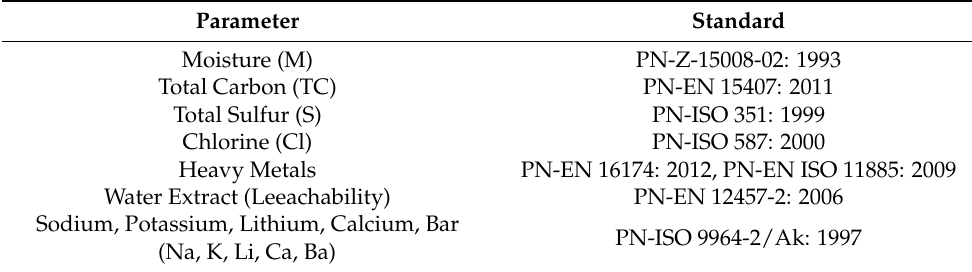
Table 1. Standards and methods of researches used in